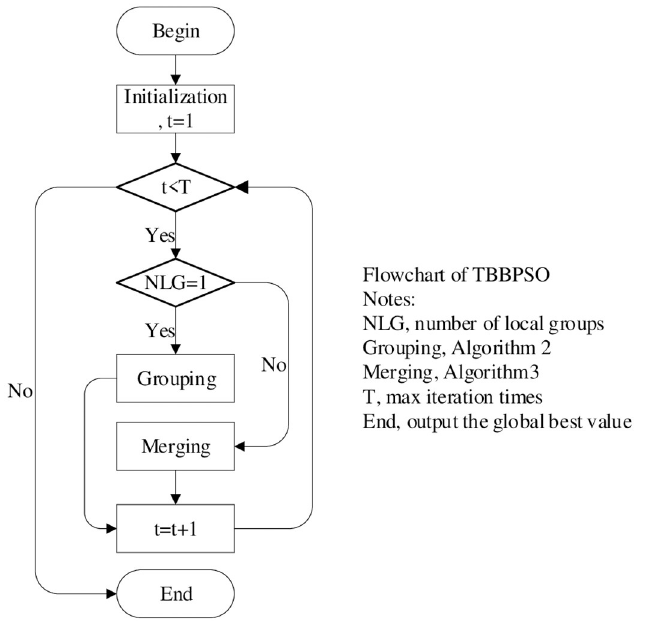
Fig 2. The flowchart of